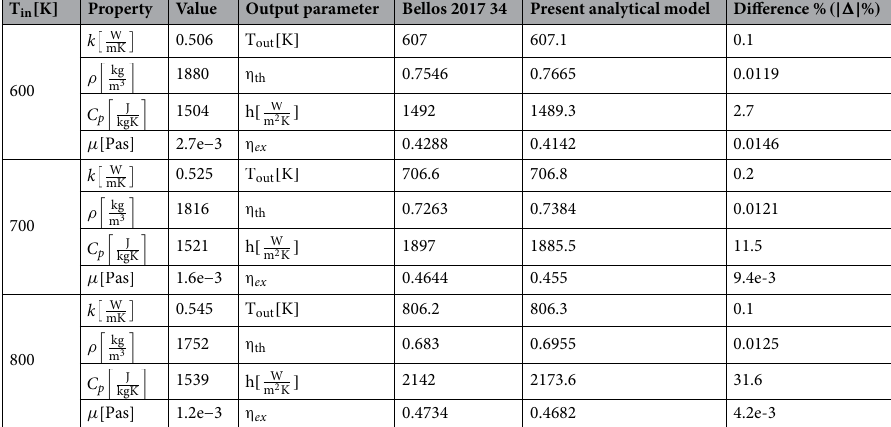
Table 4. Comparison with previous analyses from literature (for molten